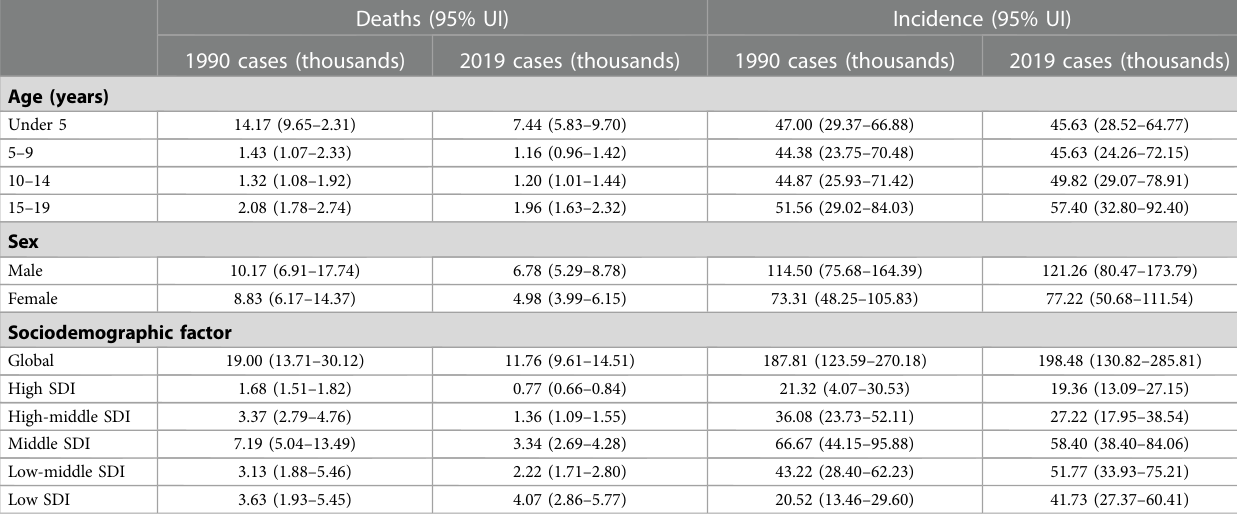
TABLE 2 The burden of childhood myocarditis and cardiomyopathy by age group, sex and SDI in 1990 and 2019. Deaths (95%